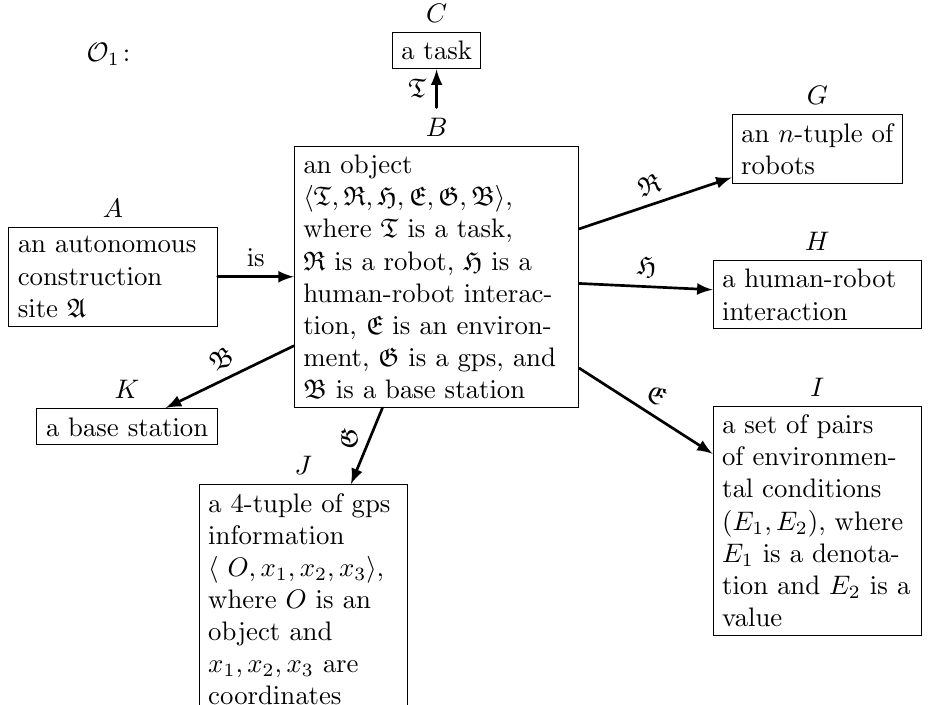
Figure 2. Olog representation of an autonomous construction